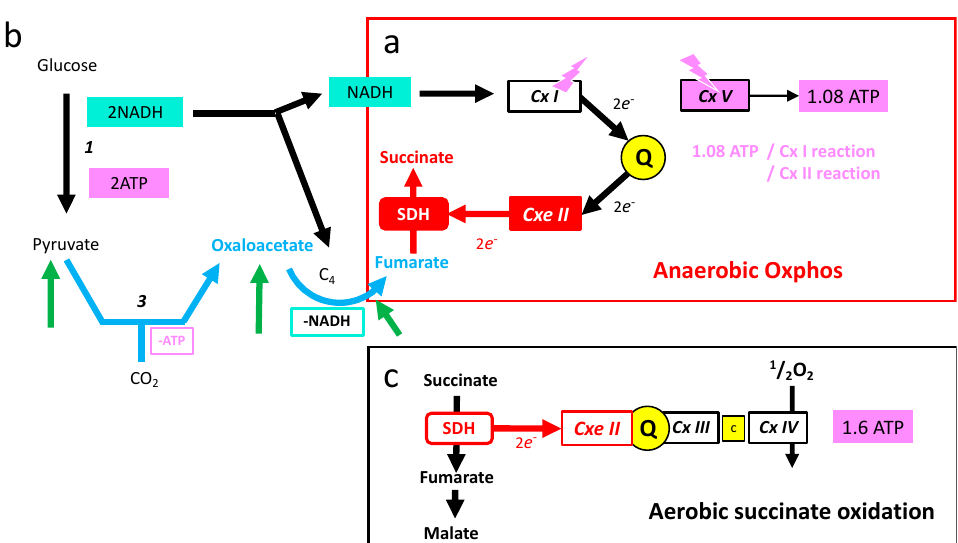
Figure 12. ( a ): Anaerobic MRC with NADH as the electron donor to complex I, and fumarate as the electron acceptor in complex II, ( b ): metabolic generation of oxaloacetate reduced in malate and fumarate; the source could be pyruvate from glucose or from amino acids; it implies CO 2 assimilation. ( c ): in the presence of oxygen (reperfusion/oxygenated domain), the high succinate concentration causes intense SDH reaction that blocks the entry of electrons from complex I. Therefore, oxidation ends with malate.